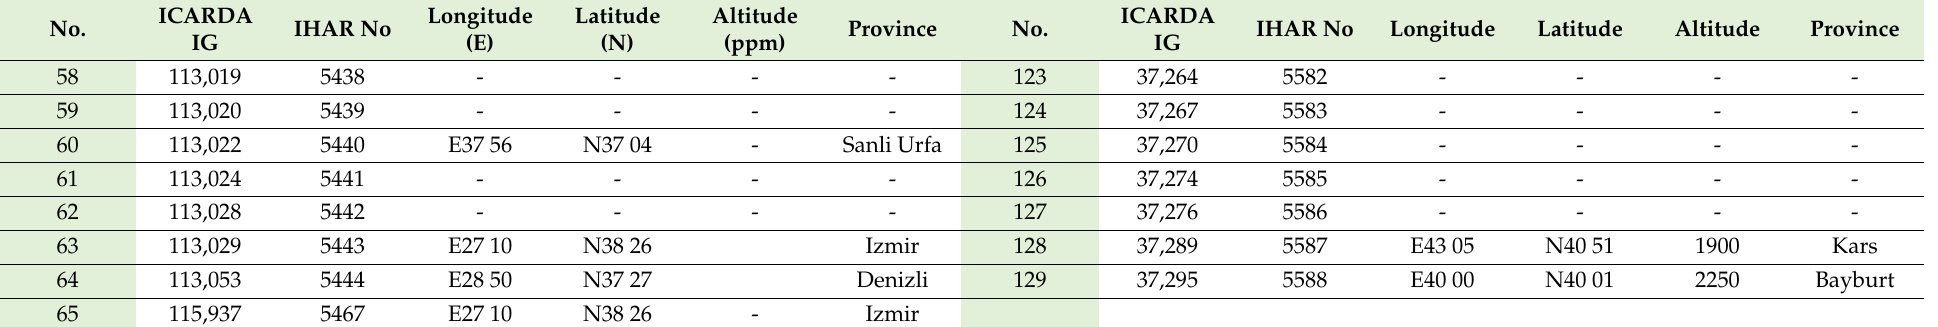
Table 2. B. graminis f. sp. hordei isolates used for artificial inoculation and their virulence spectra against resistance genes on differential set of Pallas near-isogenic lines and 8 cultivars. Pallas No. Isolines